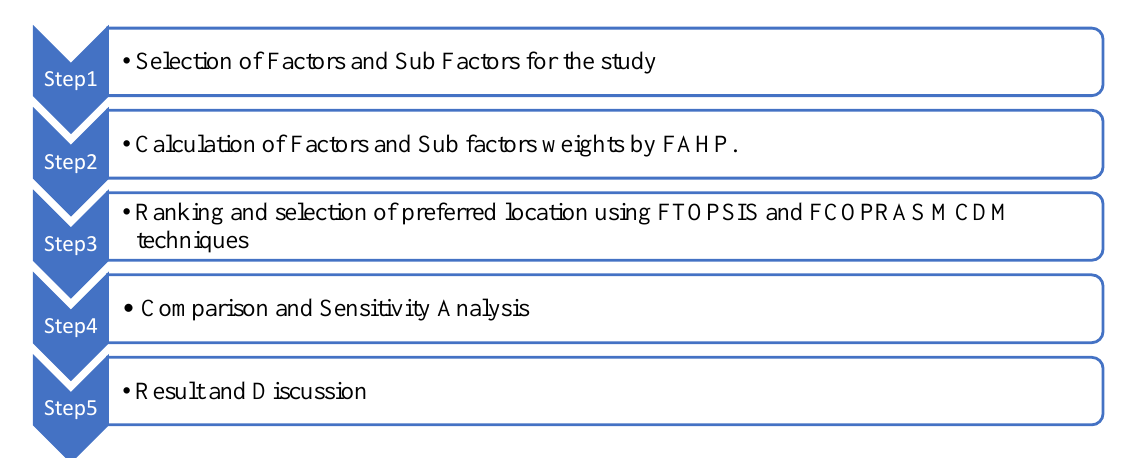
Figure 1. Structural framework of the study. FTOPSIS: fuzzy technique for order of preference by similarity to ideal solution; FCOPRAS: fuzzy complex proportional assessment; MCDM: multiple-criteria decision-making.